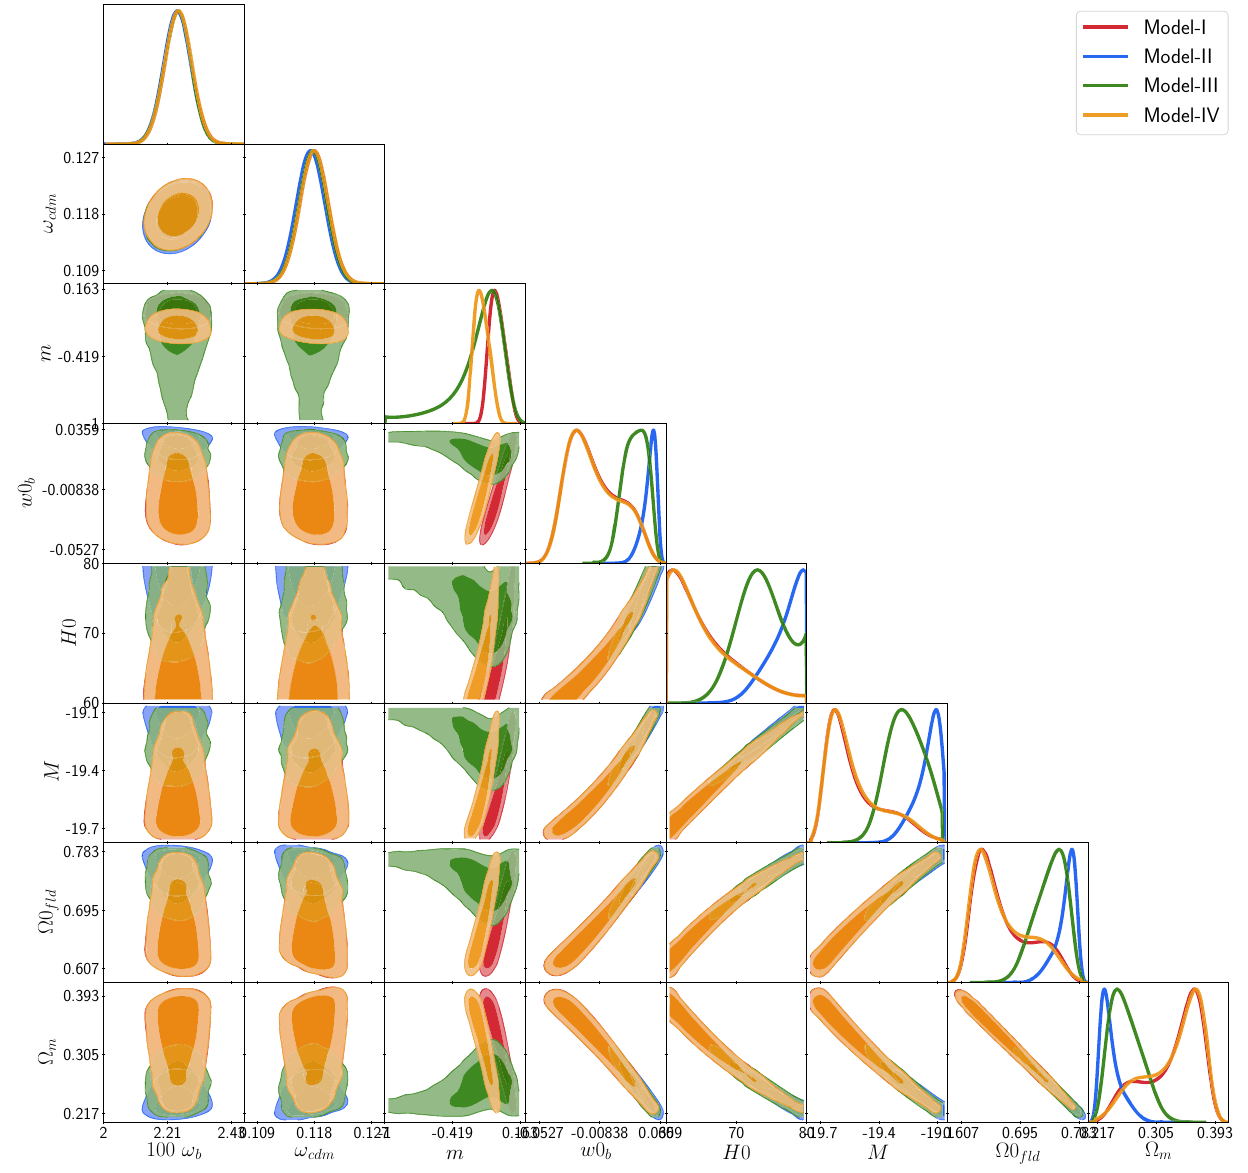
Fig. 1 Posterior distribution for the cosmological parameters of the four models using data sets I (Pantheon + BAO) and PLANCK18 prior has been considered and the equation of state for fluid is given by ω fld = ( 1 − 3 ω) ln [ ( 1 − 3 w)ρ m −